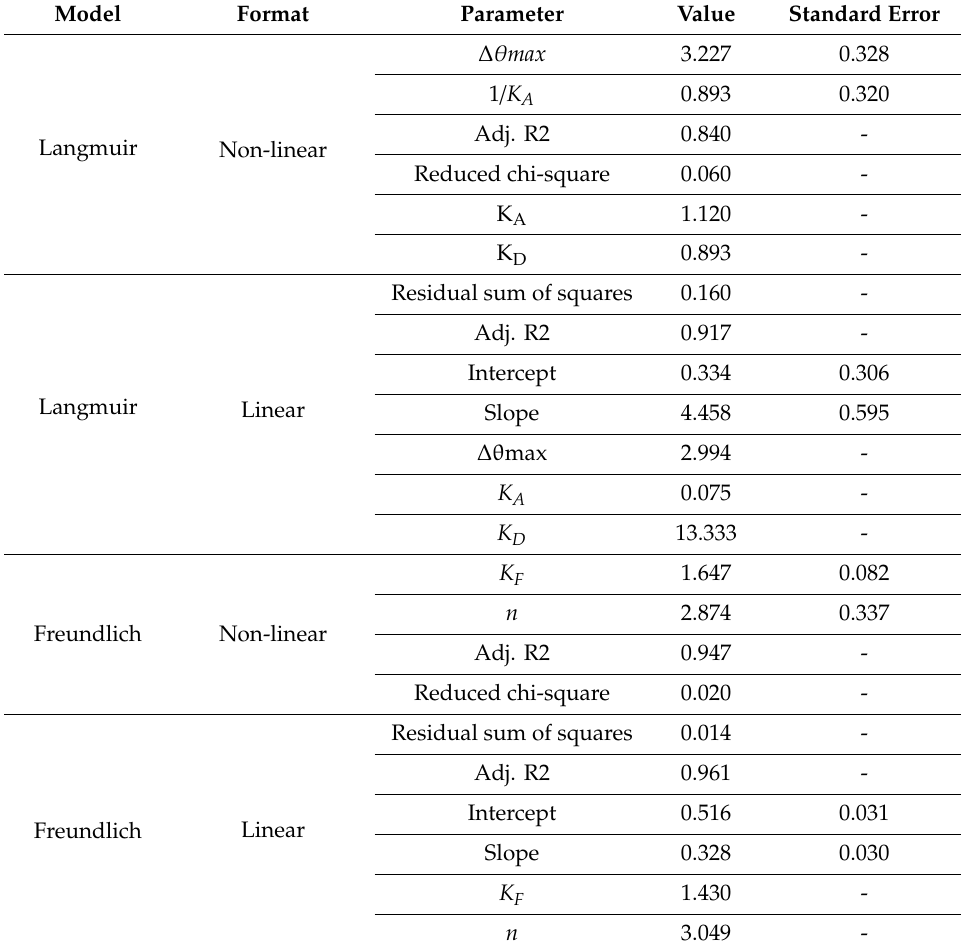
Binding parameters of acetone vapor toward single-layer chitosan-PEG-based SPR sensor extracted from nonlinear Langmuir, linear Langmuir, nonlinear Freundlich, and linear Freundlich